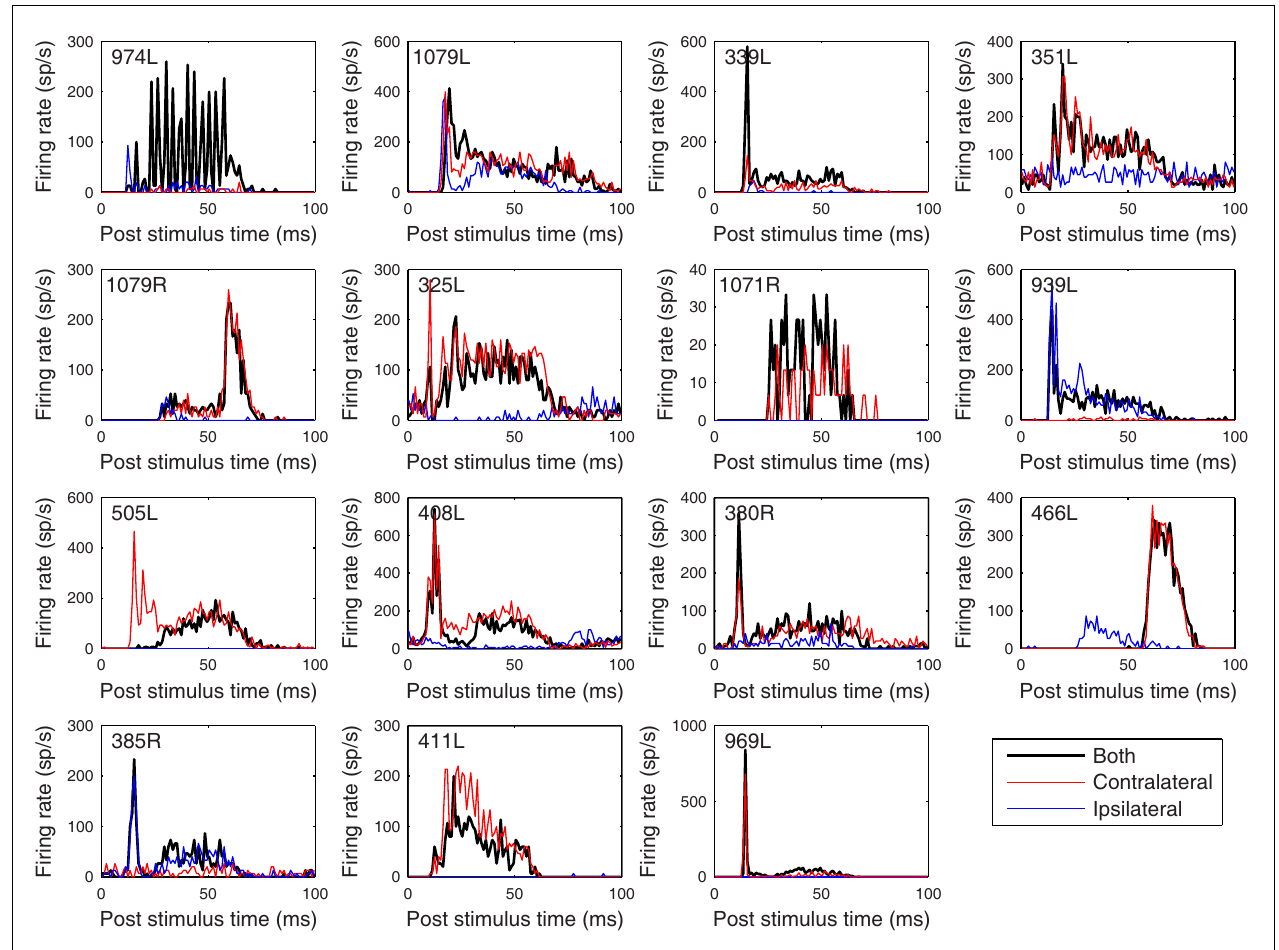
FIGURE 12 | Peristimulus time histograms to 50ms CF tones. The figure is arranged in the same order as previous figures with the tones presented binaurally (black), contralaterally (red), and ipsilaterally (blue) at 20dB above minimum threshold. Binwidth is